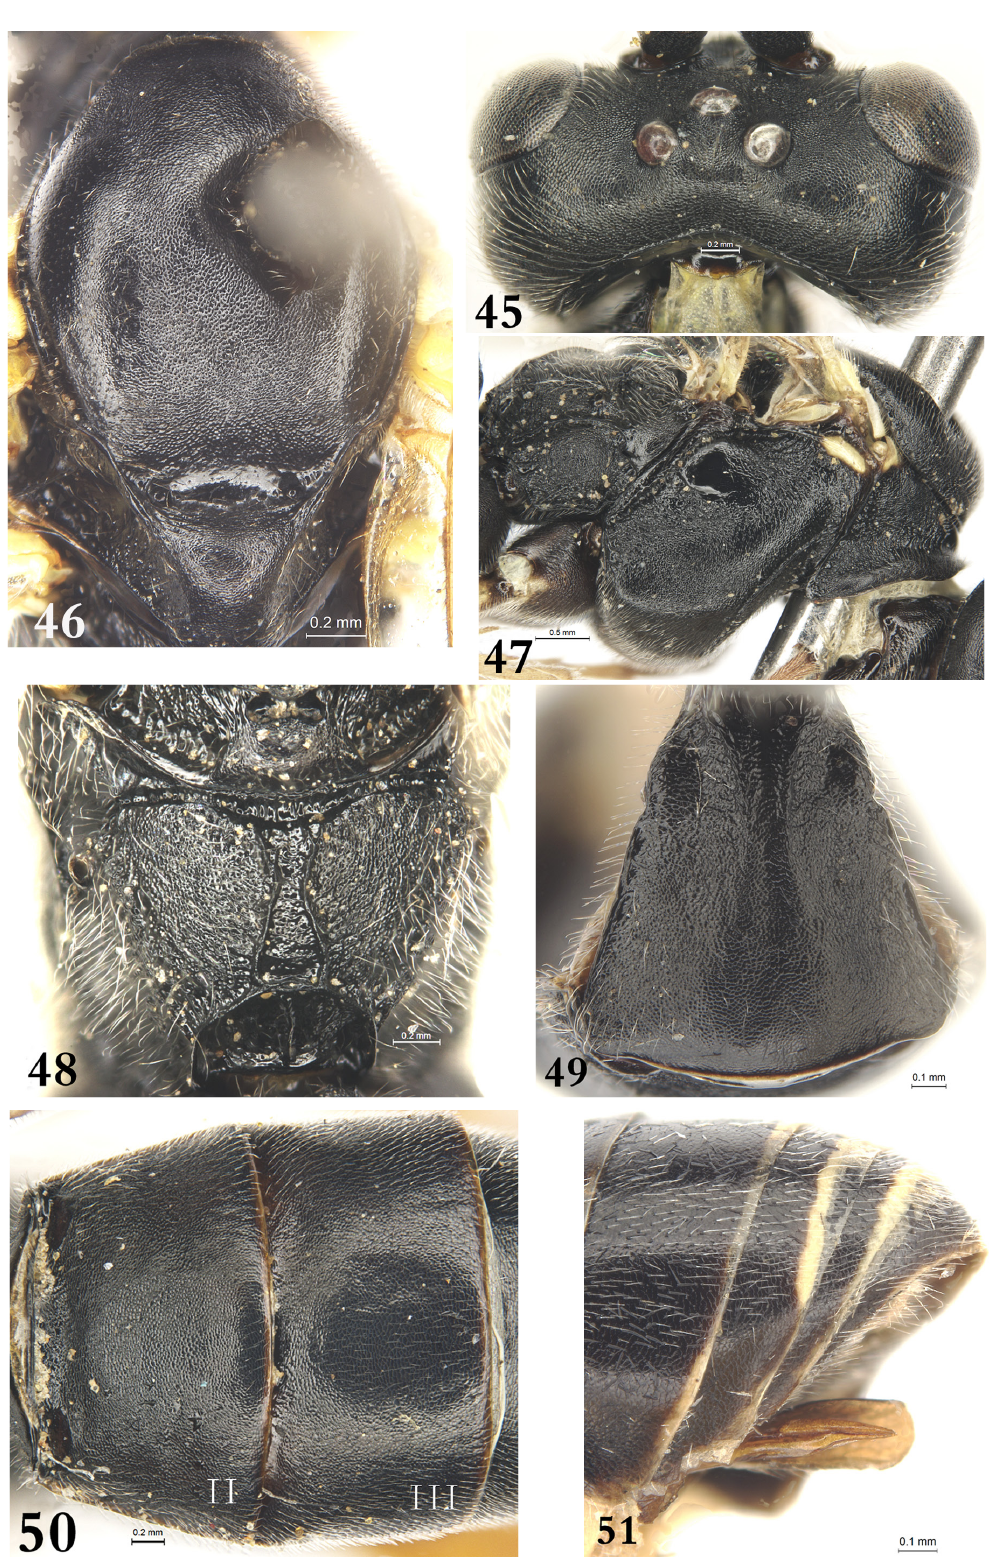
Figs 45–51. Campodorus truncatus Sheng, Sun & Li sp. nov., holotype, ♀ ( GSFGPM). 45 . Head, dorsal view. 46 . Mesoscutum and scutellum. 47 . Mesosoma, lateral view. 48 . Propodeum. 49 . Tergite 1, dorsal view. 50 . Tergites 2–3, dorsal view. 51 . Apical portion of metasoma, lateral